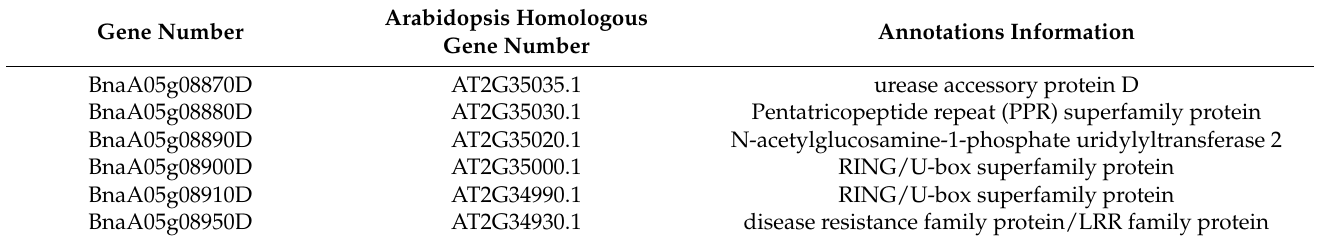
Table 1. Annotated information of candidate genes with sequence variation in the 55 kb